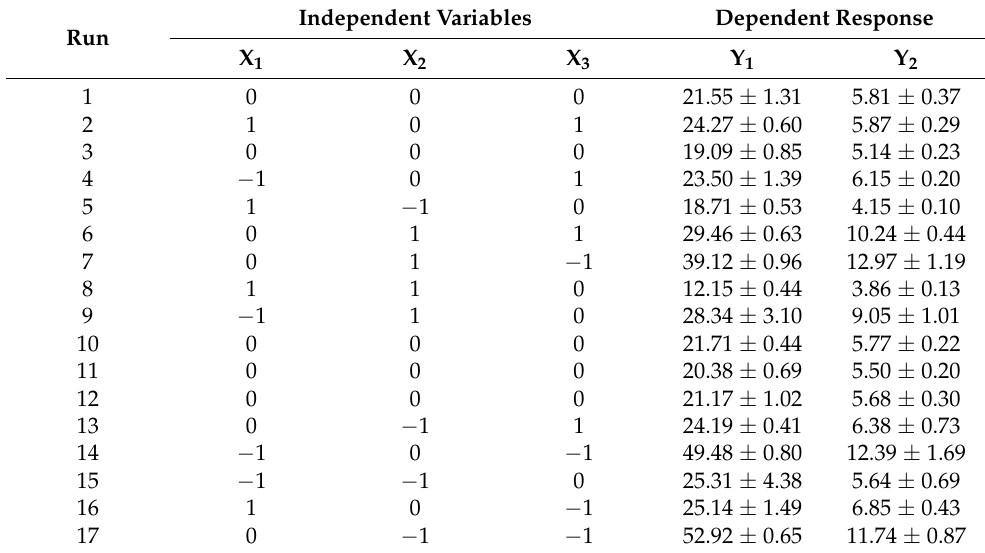
Table 1. Box–Benhken matrix and responses for the different formulations under study.